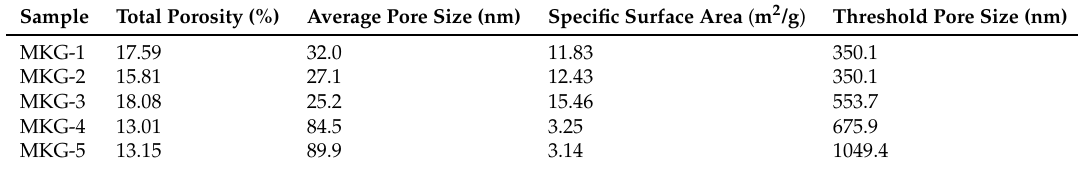
Table 3. Characteristic pore parameters of the MKG mortars form mercury intrusion porosimetry (MIP)